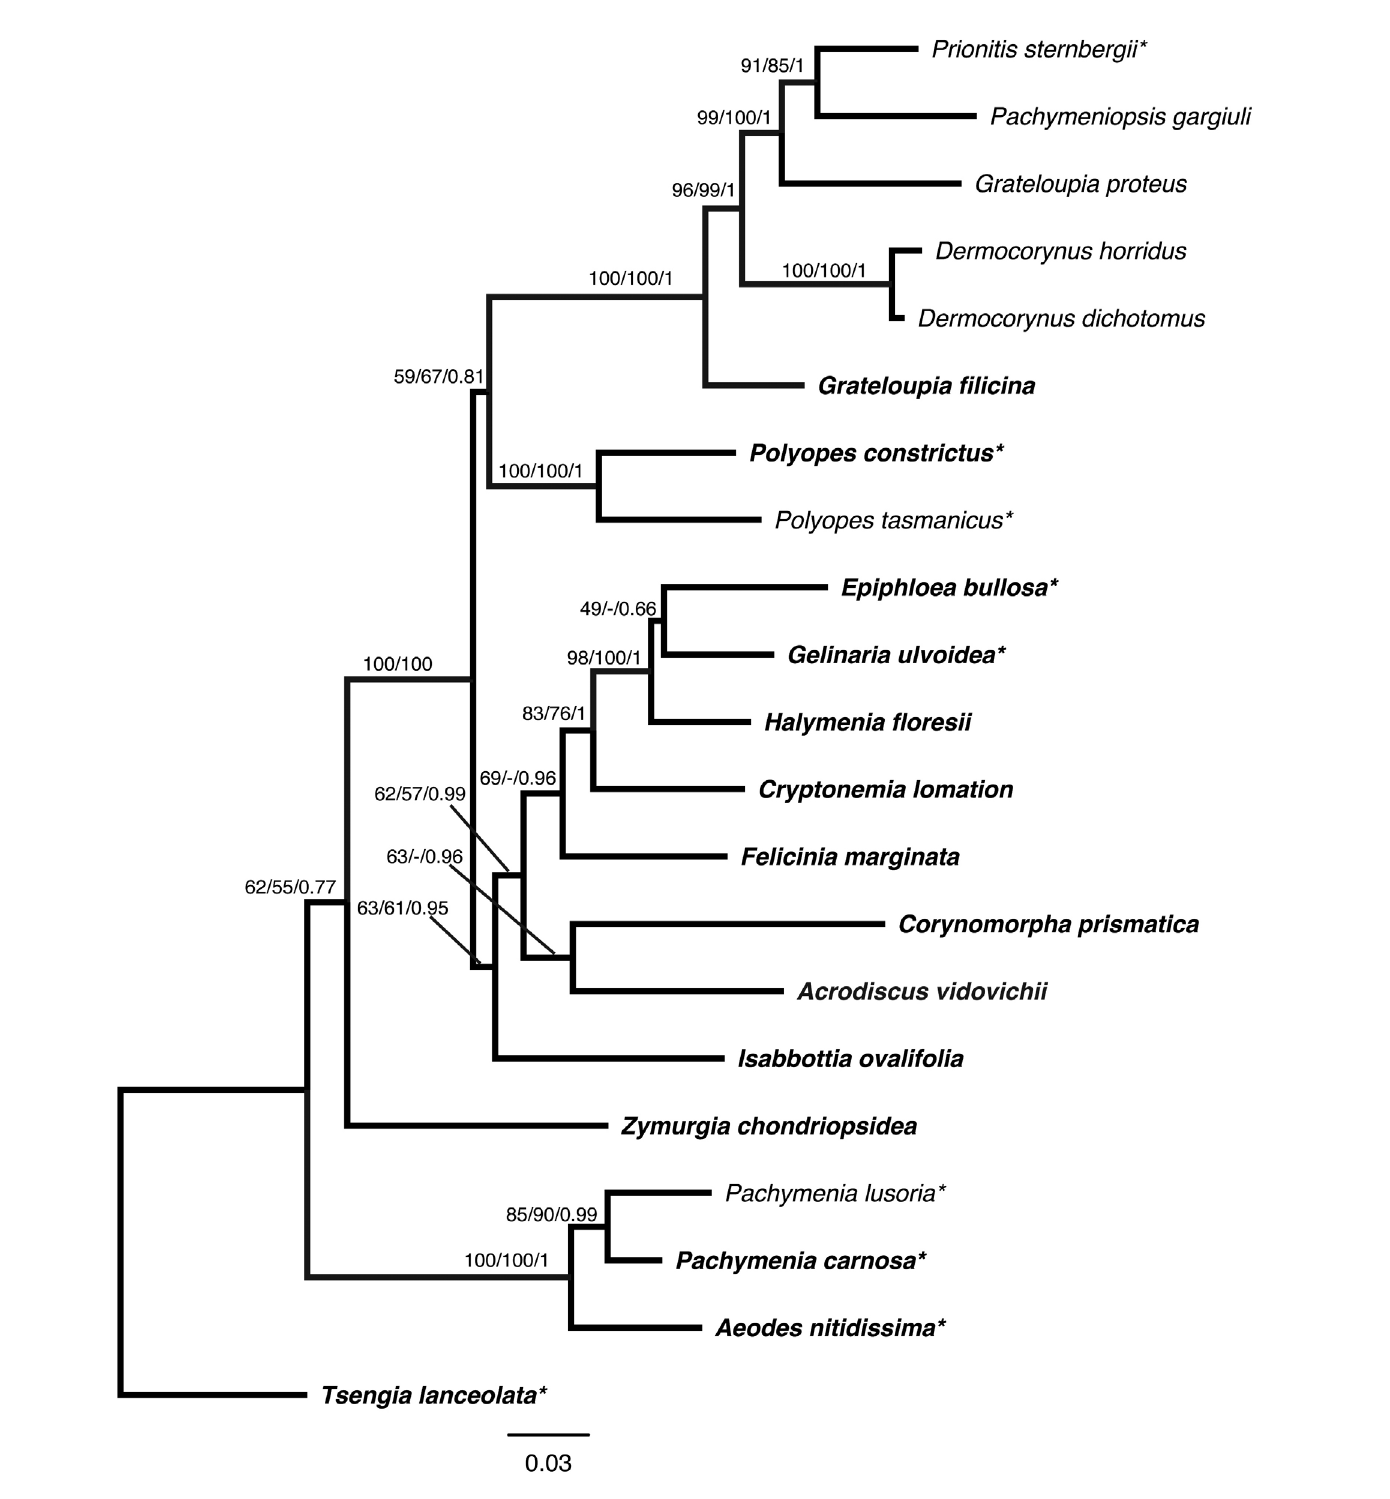
Fig. 8. ML phylogram inferred from the combined LSU- rbc L data by PhyML. Supports at nodes indicate bootstrap values (from PhyML and RaxML) and posterior probabilities inferred from Bayesian analysis. Generitype species are indicated in bold; concatenate sequences obtained from different samples for LSU and rbc L are indicated by